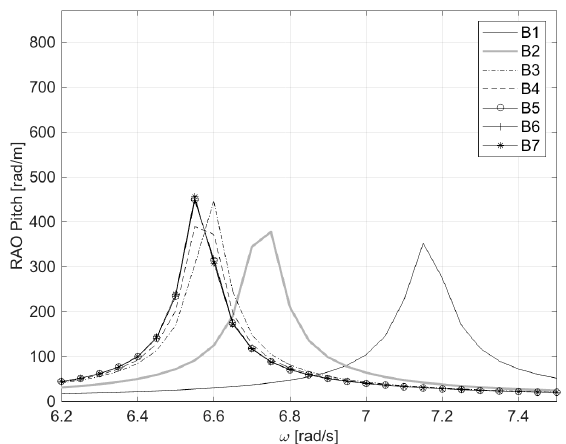
Figure A3. Comparison of pitch RAO for sensitivity analysis.